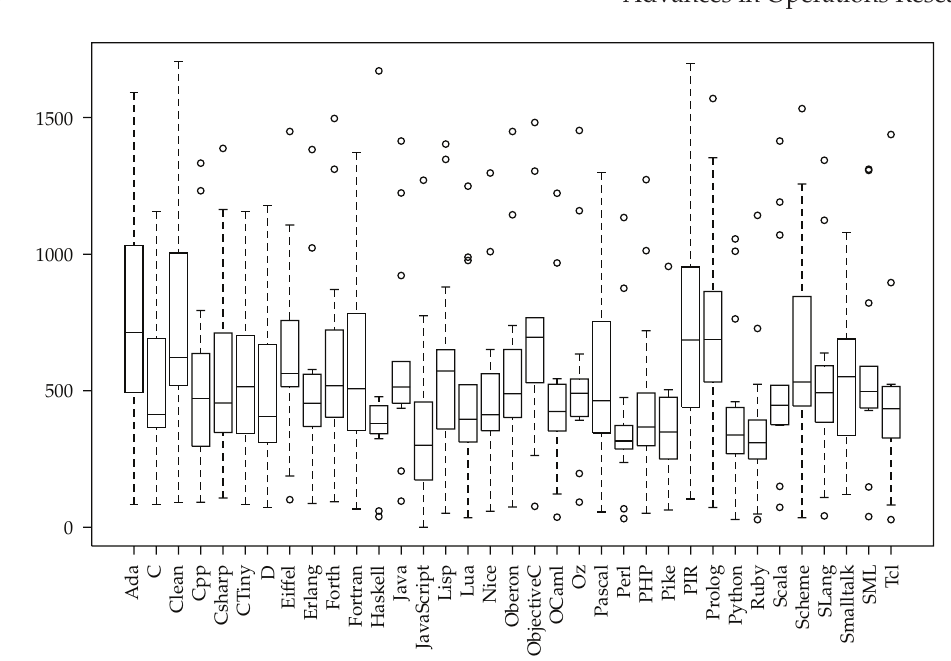
Figure 3: Distribution of source code size of each